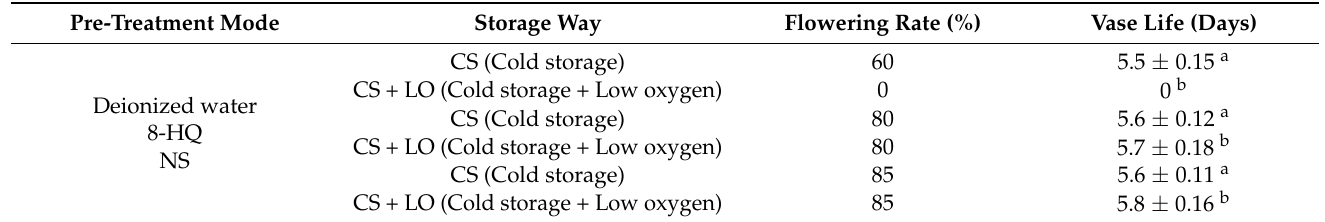
Table 3. Flowering rate and vase life of cut flowers under 8-HQ and NS pre-treatment and CS and CS + LO storage.